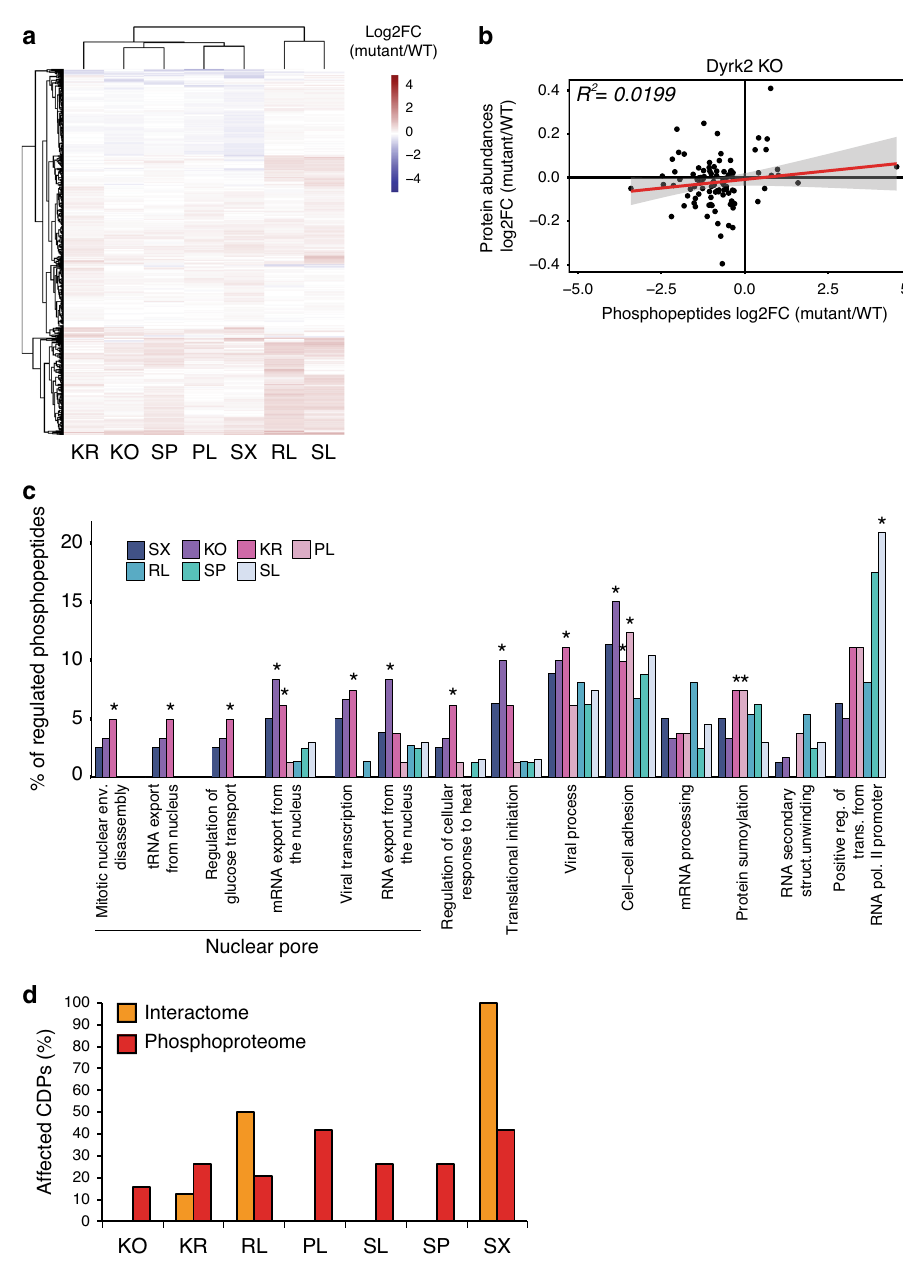
Fig. 7 Further proteomic and phosphoproteomic analysis of Dyrk2 mutants. a Heatmap showing differences in protein abundances across the different cancer-related Dyrk2 point mutants. Only those proteins that have been detected at least once as statistically signi fi cantly changed (adj. p -value ≤ 0.01, │ log2FC │ > 0.5) are displayed. b Correlation of log2 fold changes between signi fi cantly regulated phosphopeptides and the corresponding protein identi fi ed in DYRK2 KO cells (adj. p -value ≤ 0.05). c Biological processes GO-term analysis of regulated phosphopeptides identi fi ed in the different Dyrk2 mutants. The asterisk indicates an signi fi cant enrichment of the GO term ( p -value ≤ 0.05). The p -value for GO-term enrichment was obtained from DAVID 32 . d Effect of Dyrk2 point mutations on the interaction and phosphorylation of cancer driver proteins identi fi ed in the interaction and phosphoproteome analysis of this study ( │ log2FC │ > 1, adj. p -value ≤ 0.05). The statistical analysis and p -value calculation (adj. p -value (FDR)) was performed within the mapDIA package 60 . Source data are provided as source data fi